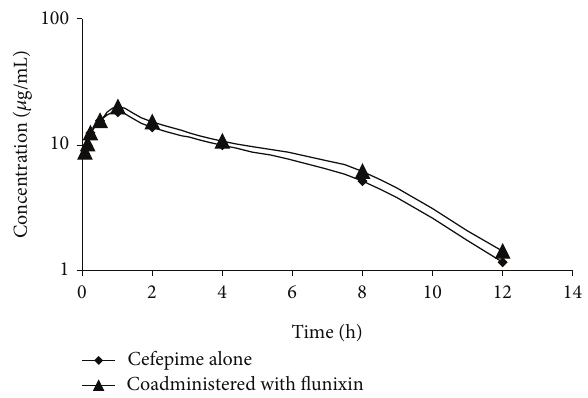
Figure 2: Serum concentrations of cefepime alone and in combina- tionwithflunixinfollowingasingleintramuscularinjectioningoats.